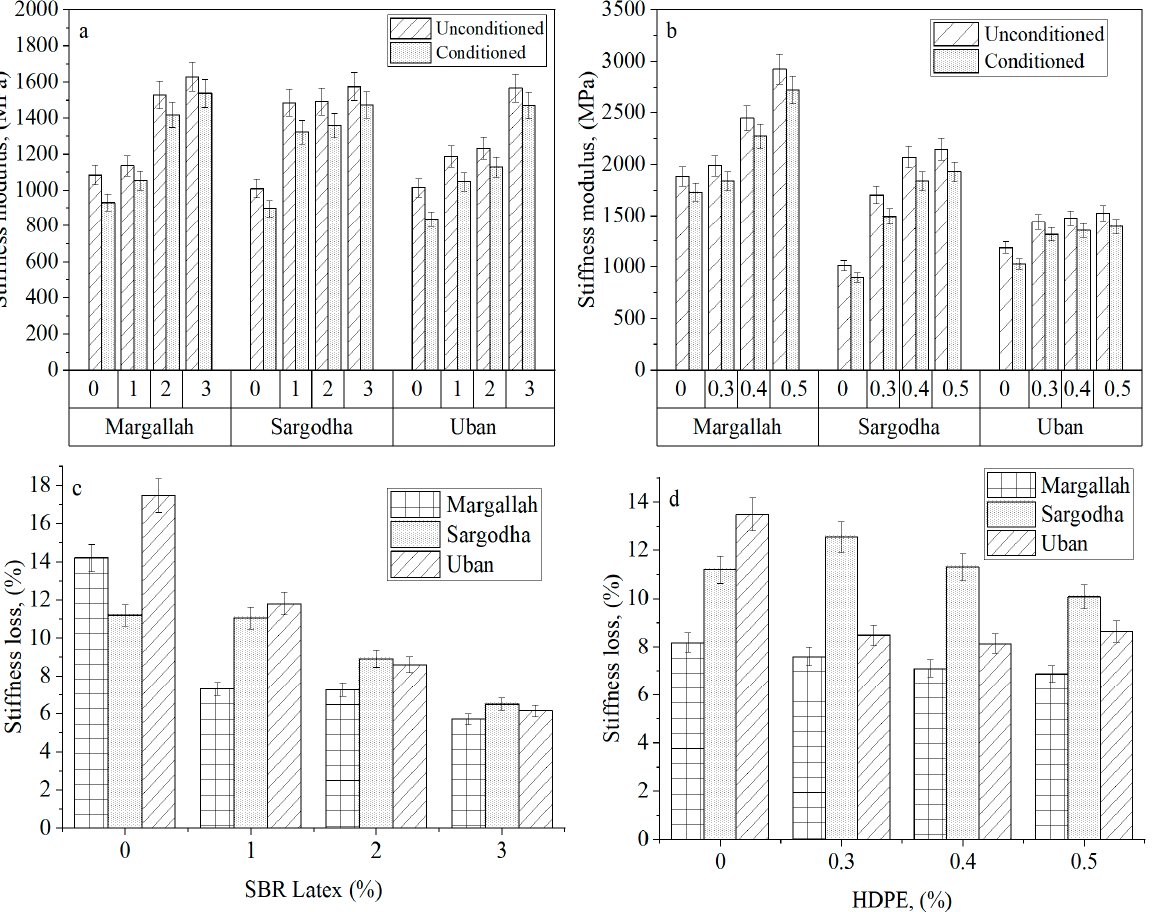
Figure 5. Results of ( a ) ITMT modified with SBR Latex, ( b ) ITMT modified with HDPE, ( c ) stiffness loss in SBR Latex modified samples, and ( d ) stiffness loss in HDPE modified samples .